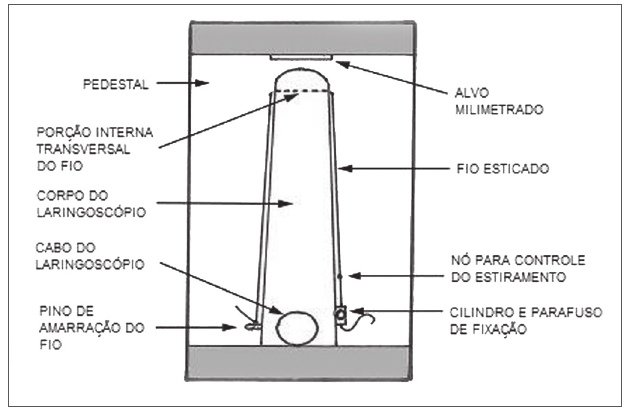
Figura 3. Vista superior do laringoscópio e do sistema de